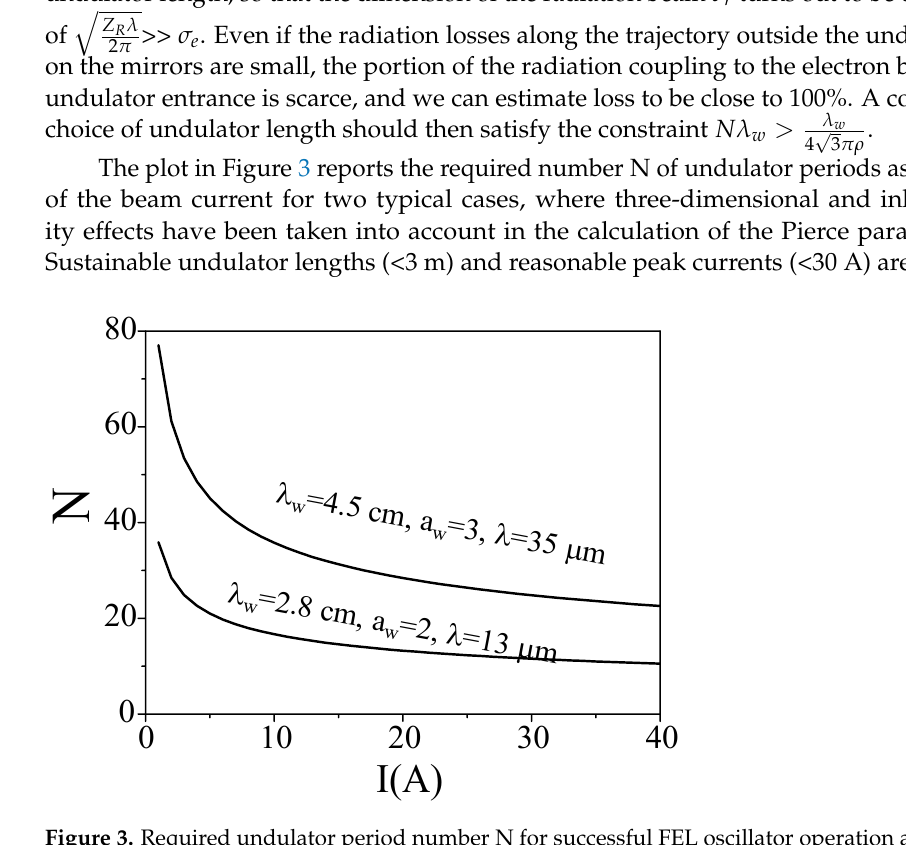
Figure 3. Required undulator period number N for successful FEL oscillator operation as a function of electron beam current I(A) for two typical cases.